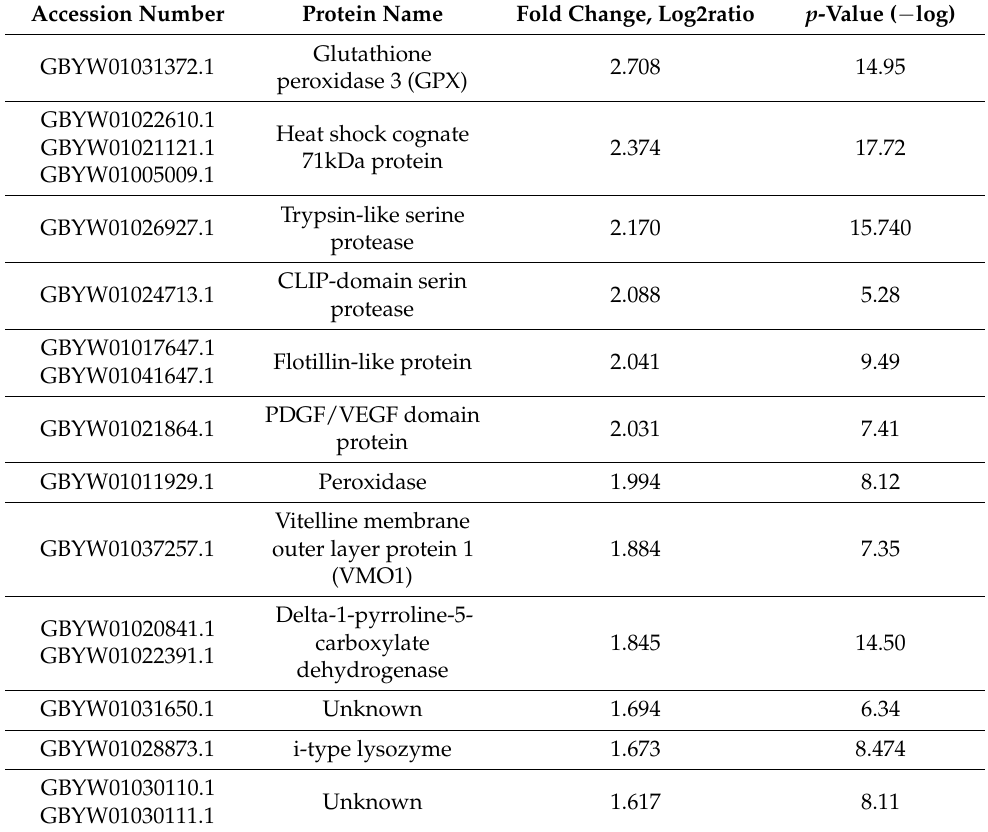
Figure 3. Differentially expressed proteins. Volcano plot showing differentially expressed proteins in hemocytes six h after saline injection. Significantly higher expressed proteins are shown in blue color and lower expressed proteins are shown in red color. The red frames indicate significant according to our criteria (Log2Ratio > 0.58, − log2 p value > 5). Table 1. The twelve most upregulated proteins after saline injection. Accession number in the tran- scriptome database for P. leniusculus (BioProject PRJNA259594), TSA: GBYW01000001:GBYW01075939 is given, limit Fold change Log2ratio > 0.58, p ( − log)